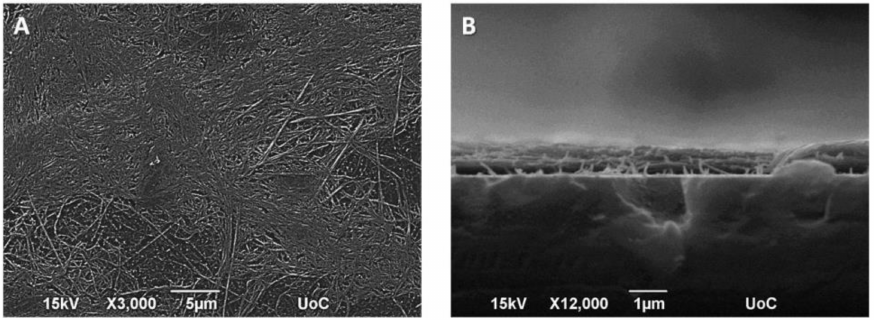
Figure 4. SEM images showing the morphology of fibrous collagen networks ( A ); SEM image of a sample cross-section showing the fibrous collagen scaffold prepared on a glass substrate ( B